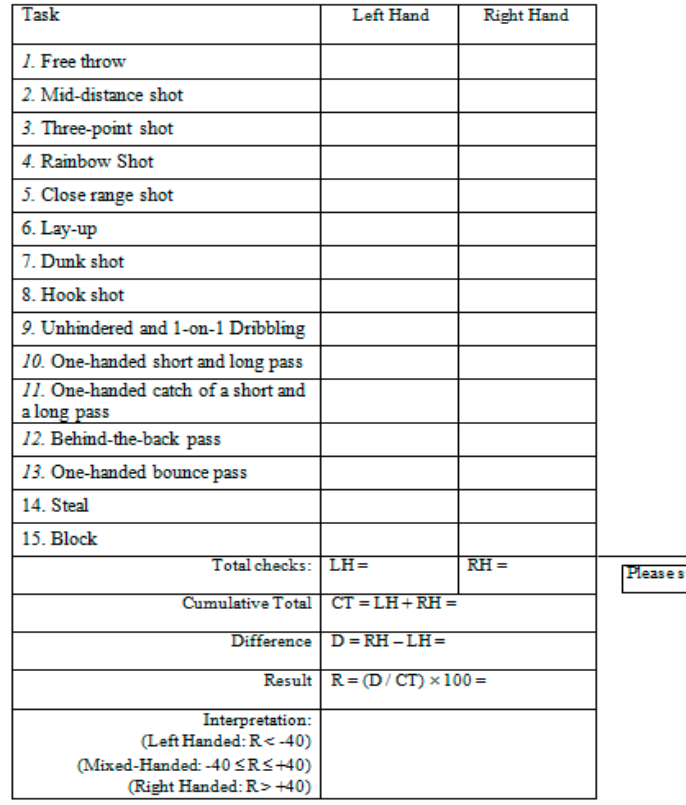
Figure 1. Basketball Handedness Inventory ( BaHI) with instructions.